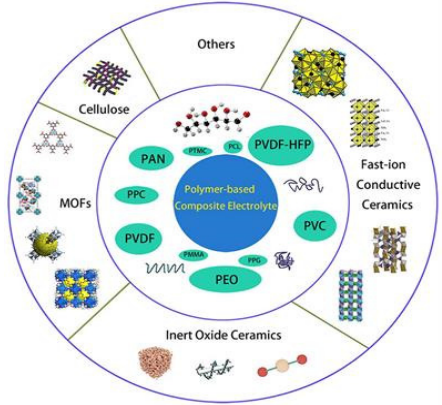
Figure 11. Classification of certain composite electrolytes doped with polymers